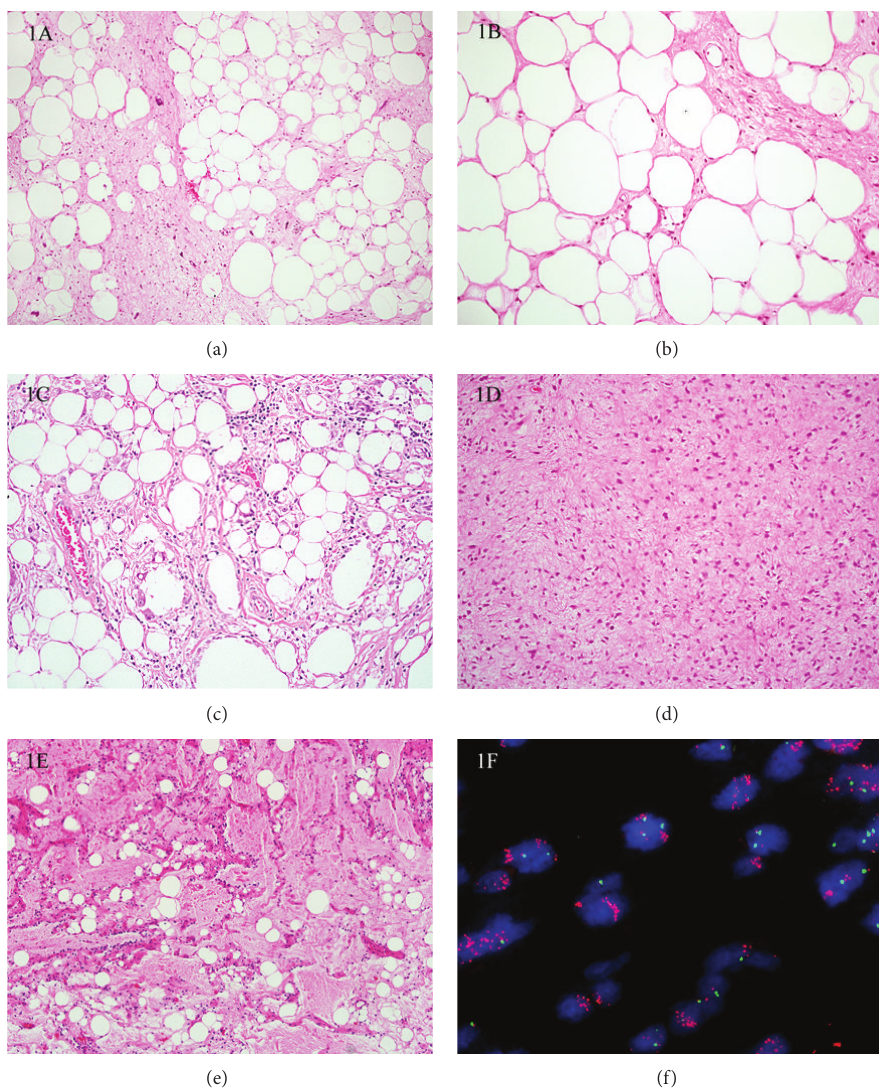
Figure 1: (a) Well-differentiated liposarcoma (WDL). This typical example shows differentiated adipose tissue intersected by thick fibrous septa containing spindle cells with enlarged, hyperchromatic nuclei. (b) This WDL shows lobules of mature adipose tissue, with fibrous septa containing minimal atypia, and can be difficult to distinguish from fibrolipoma or lipoma with fat necrosis. (c) Fat necrosis. This can be extensive, with prominent histiocytes containing plump nuclei, making it difficult to distinguish from WDL. (d) Dedifferentiated liposarcoma (DDL) showing a “low grade” pattern of dedifferentiation can be mistaken for a variety of lesions, including benign neoplasms such as neurofibromas, those of intermediate biologic potential such as fibromatosis, or with other sarcomas such as low grade fibromyxoid sarcoma. FISH for assessment of MDM2 amplification status is useful in supporting the diagnosis of DDL. (e) This myxoid variant of DDL bears a striking resemblance to myxoid liposarcoma (MLPS). Evidence of MDM2 amplification with FISH is strongly supportive of DDL, as MDM2 amplification is not described in MLPS. (f) Fluorescence in situ hybridization for MDM2 amplification status. The green CEP 12 signals are located on the centromere of chromosome 12 and the red MDM2 signals are located on the long arm of the same chromosome